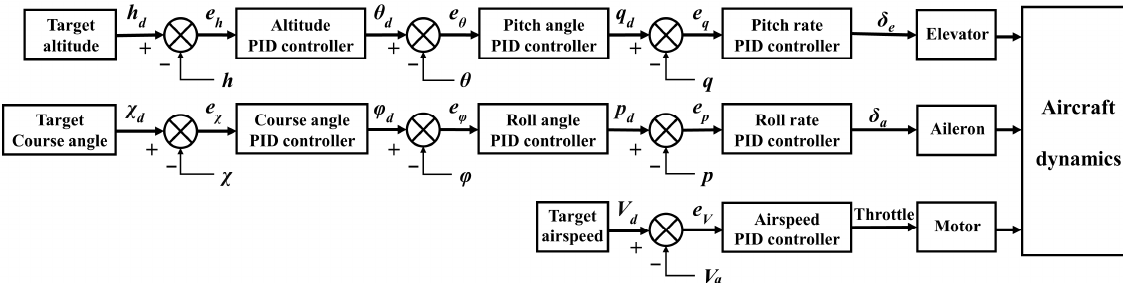
Figure 20. Block diagram of the stability control system.